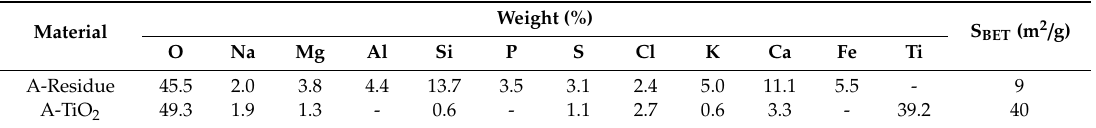
Table 2. Energy dispersive X-ray spectroscope (EDX) and Brunauer-Emmett-Teller (BET) surface area results of A-Residue and A-TiO 2.